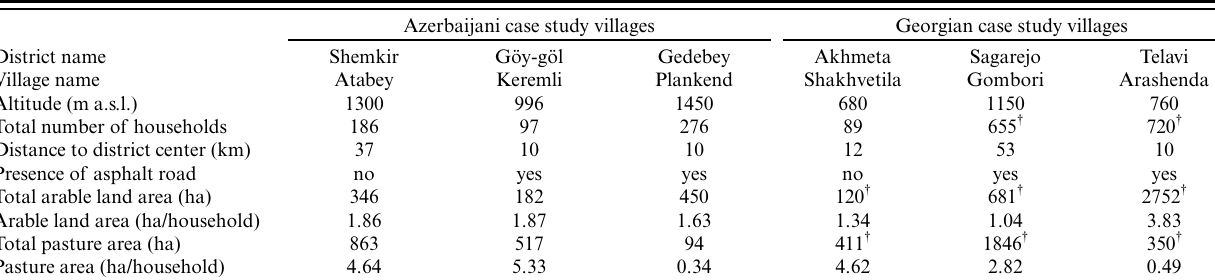
Table 1 . Selected case study